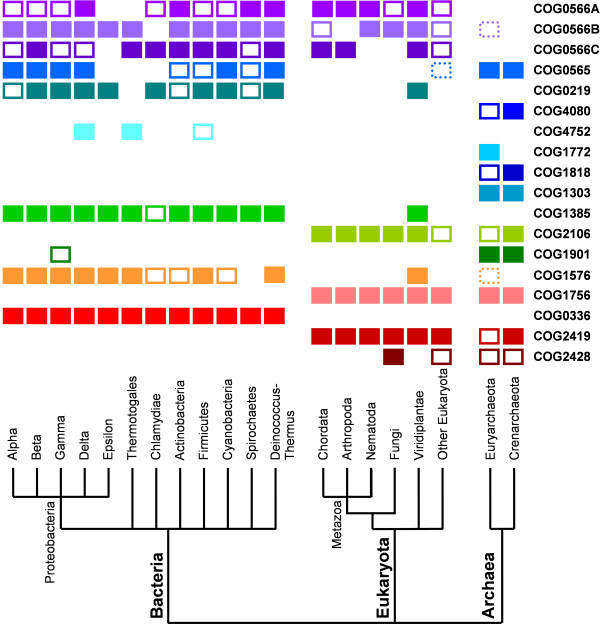
Phyletic patterns of SPOUT families analyzed in this work, analyzed with respect to the fully sequenced genomes of organisms from the tree Domains of Life. Full squares correspond to taxons, where at least 50% of fully sequenced genomes contained the member of a given COG. Note that taxons comprise different numbers of representatives, e.g. Thermotogales contain only one species, Thermotoga maritima. For taxons with more than one fully sequenced genome, the presence of a COG member in less than 50% of genomes is indicated by an empty square, and the presence of just a single member is indicated by a dotted square.